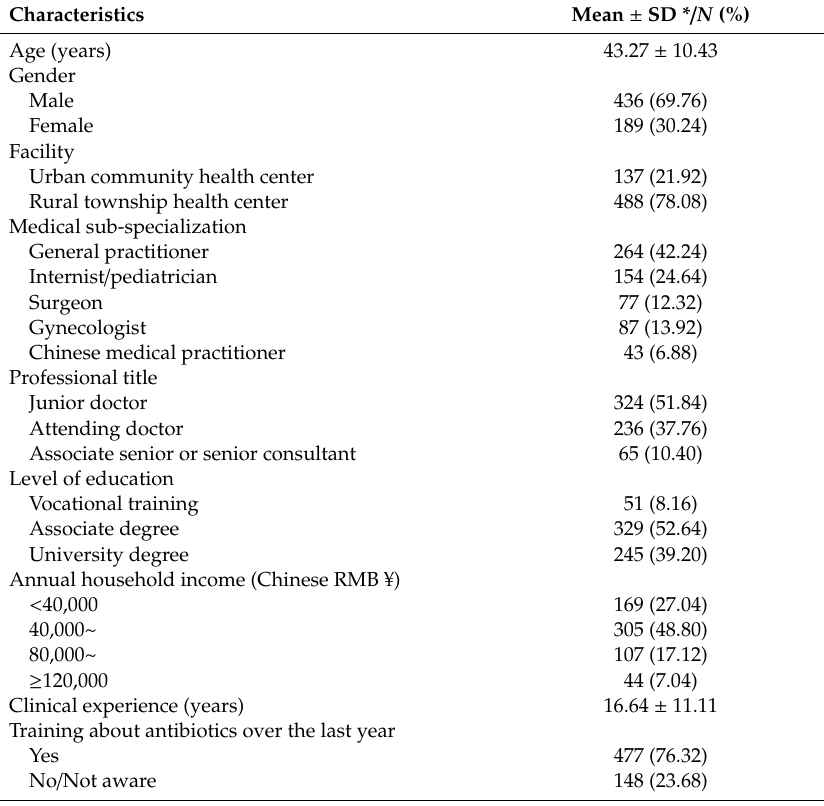
Table 1. Characteristics of